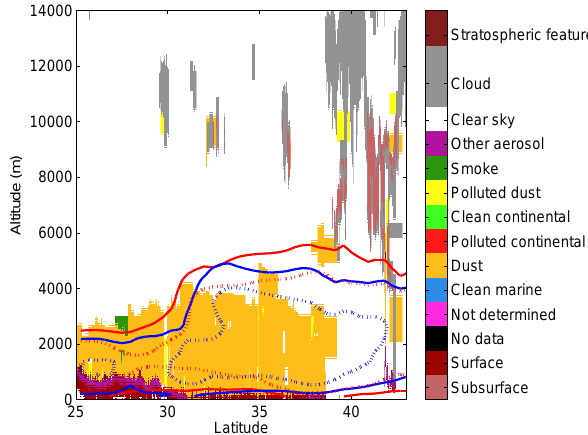
Fig. 2. Vertical profile of aerosols measured by CALIOP on 1 November 2008. The corresponding trace is plotted in Fig. 1a. The AOD of dust aerosols simulated in RegCM-4 by REF is indi- cated with the red line, by NEW with the blue line (solid line: dust AOD=0.01, dashed line: dust AOD=0.03).